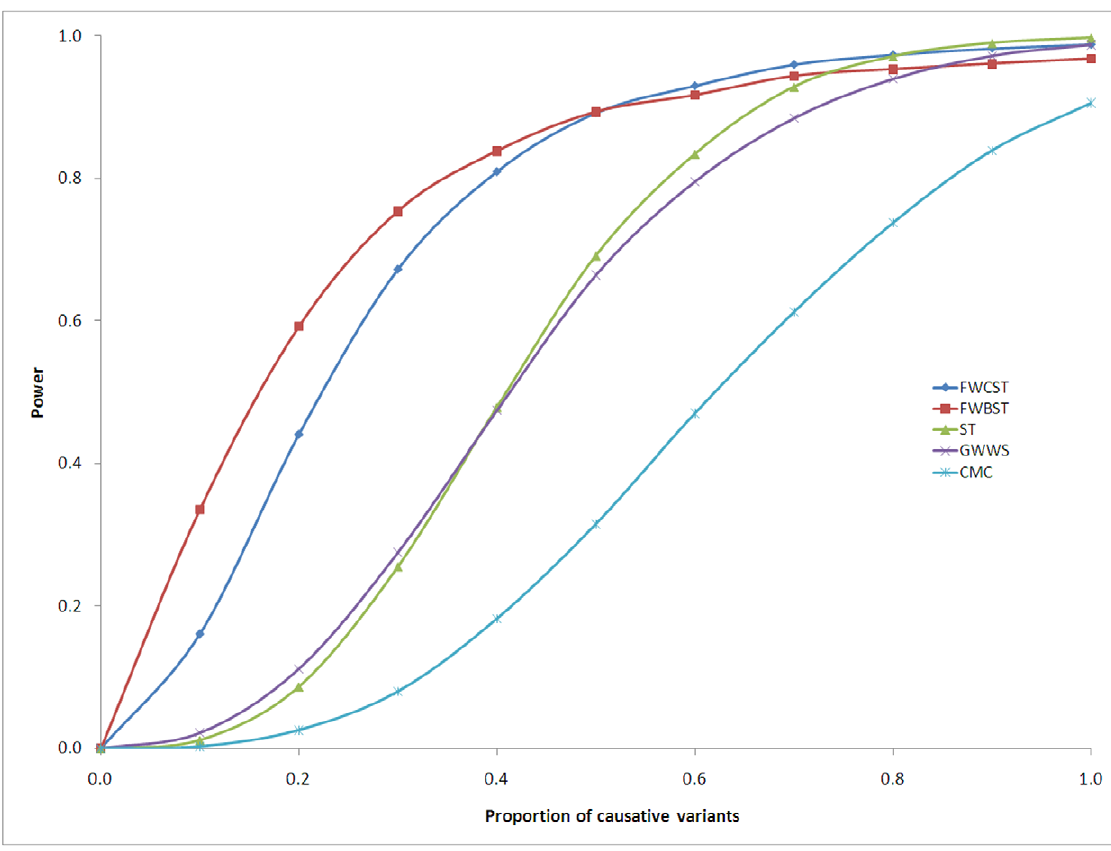
Figure 4. Power with proportion of causative variants. Genotype data of a gene with 1,500 nucleotides are simulated. A pool of 50,000 quantitatively phenotyped individuals is generated, from which 1,000/1,000 individuals with the lowest and highest phenotypes are selected and labeled as control/case subjects. Causative variants explain cumulatively 0.5% of the total phenotypic variation, of which 90% is explained by rare variants, and the remaining 10% by common variants. The sensitivity and specificity of prediction algorithms are set to 0.8 and 0.15, respectively. Power is estimated on 10,000 replicates, defined as the proportion of replicates in which the gene is detected at the significance level 1.0E-6. Abbreviation: FWCST, the proposed functional variant weighted continuous sum test; FWBST, the proposed functional variant weighted binary sum test; ST, the sum test without weighting; GWWS, the group-wise weighted sum test [16]; CMC, the combined multivariate collapsing test [15].